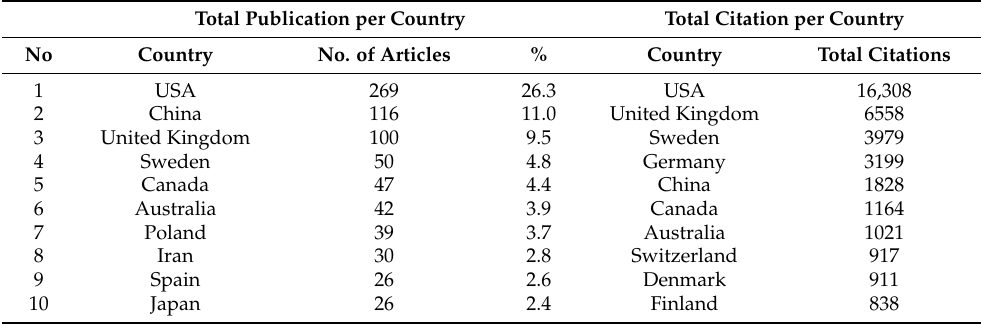
Table 1. The top 10 countries contributed to the premature mortality studies according to total publication and total citation.